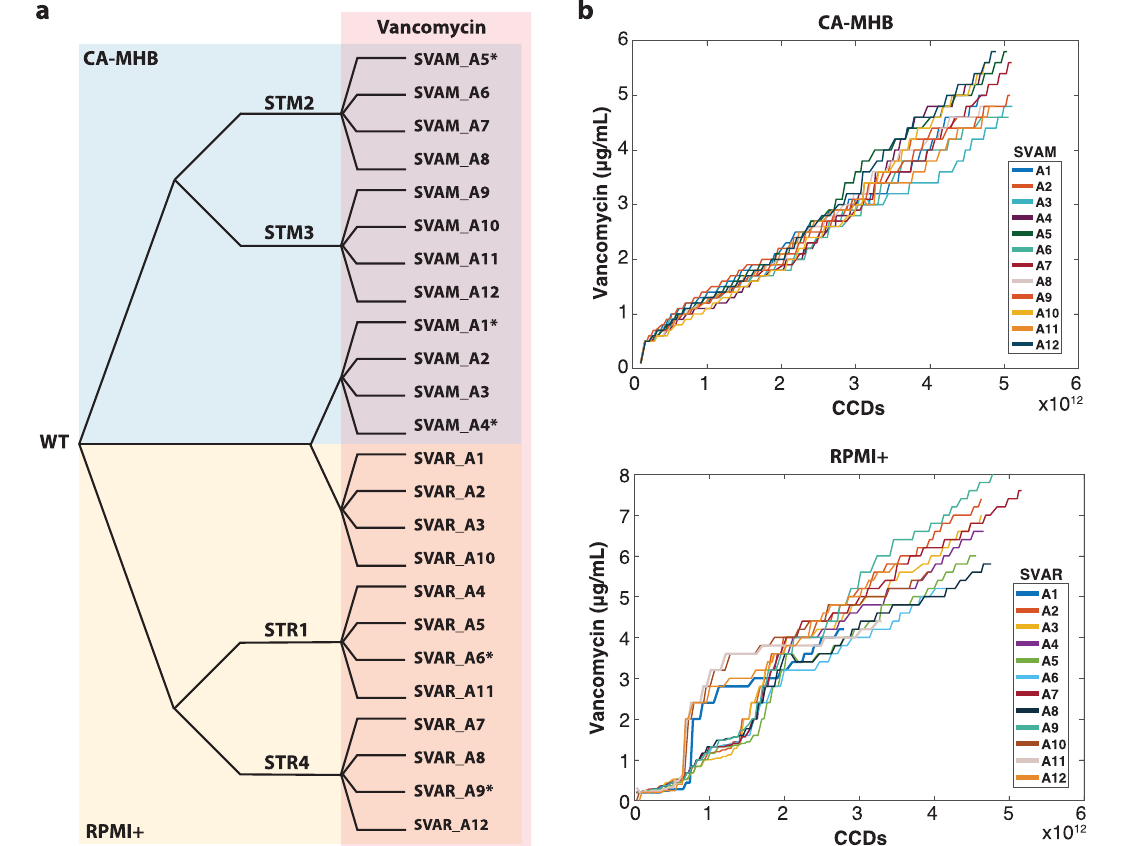
Fig. 1 Tolerization adaptive laboratory evolution. a Experimental design. Wild-type (WT) S. aureus TCH1516 was used as starting strain along with strains which were initially adapted to each media condition 12 . Strains were tolerized under CA-MHB (blue) and RPMI + (yellow) media conditions with increasing concentrations of vancomycin (red). Isolate naming from each lineage is listed. b Plots showing the stepwise increase of vancomycin throughout the TALE experiments. * denotes hyper-mutators. STM: Staphylococcus aureus adapted to CA-MHB. STR: Staphylococcus aureus adapted to RPMI + . SVAM: Staphylococcus aureus tolerized to vancomycin in CA-MHB. SVAR: Staphylococcus aureus tolerized to vancomycin in RPMI + . CCDs: cumulative cell